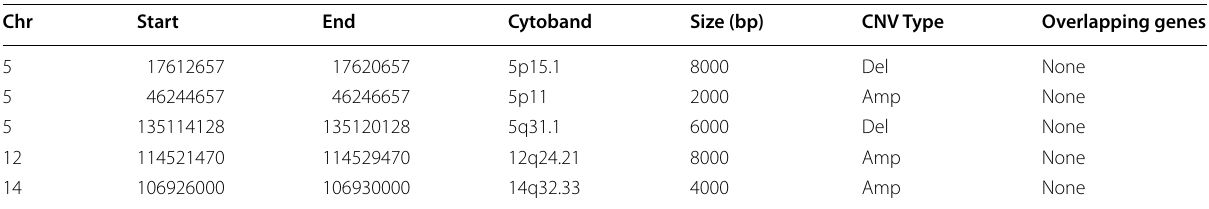
Table 7 Copy number variants unique to the affected member of family 2 (II-2-1) as compared to unaffected MZ twin